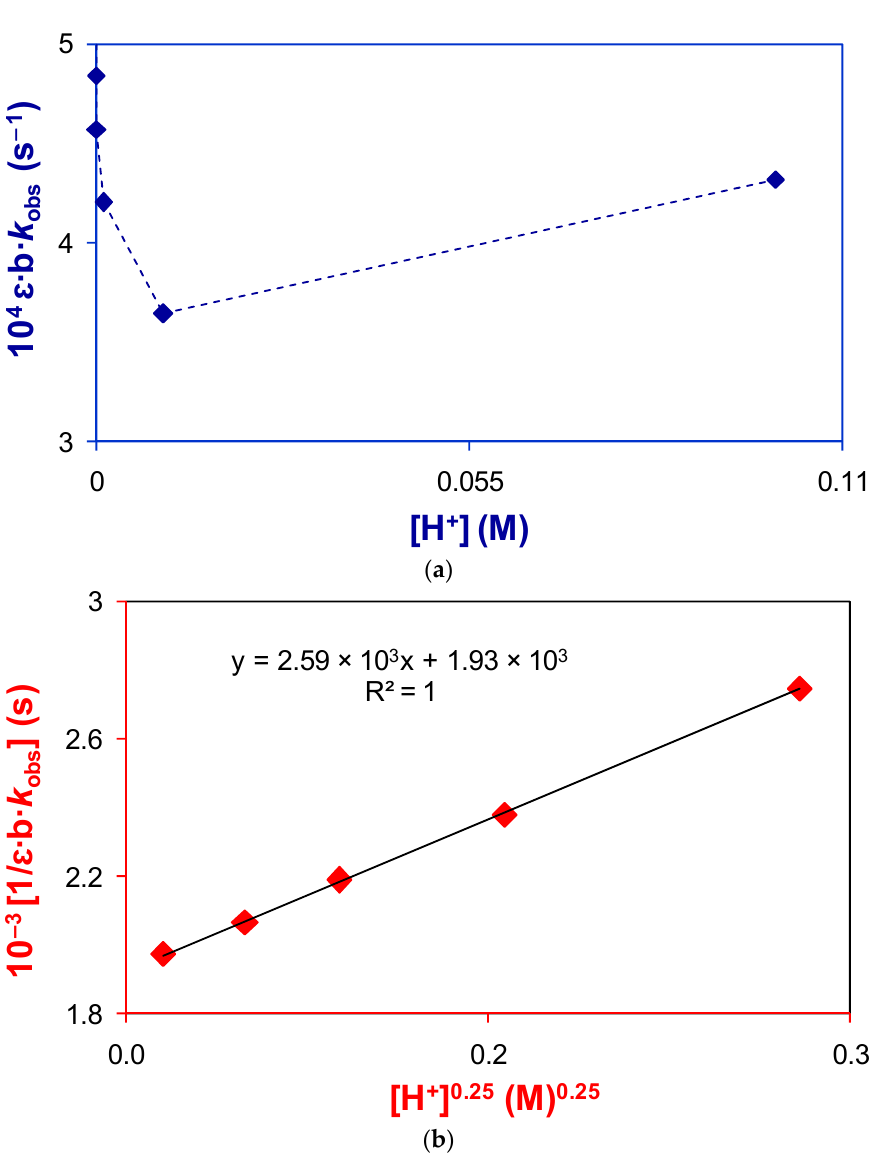
Figure 4. ( a ) Plot illustrating the rate constant as a function of rising proton concentration. ( b ) Inverse fractional (0.25) order plot with respect to proton (H +